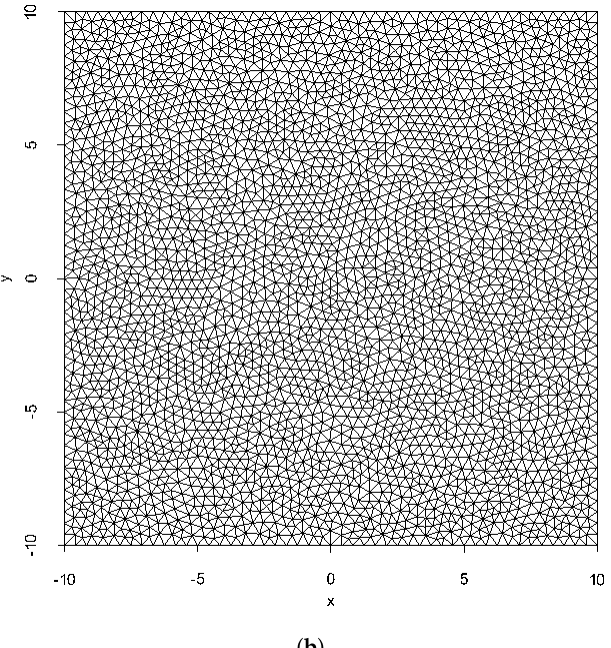
Figure 5. Two-dimensional meshes for the verification process. ( a ) 2500 hexahedra; ( b ) 6172 triangular prisms.